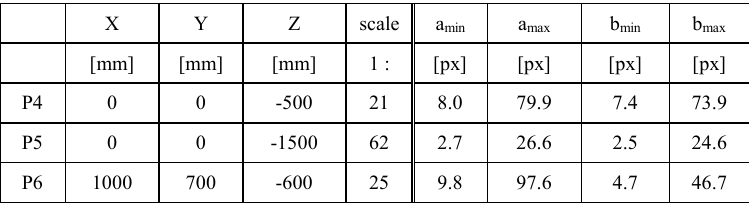
Table 2: Object point coordinates, imaging scale and resulting semi-axes for SLR camera setup 3.3.2